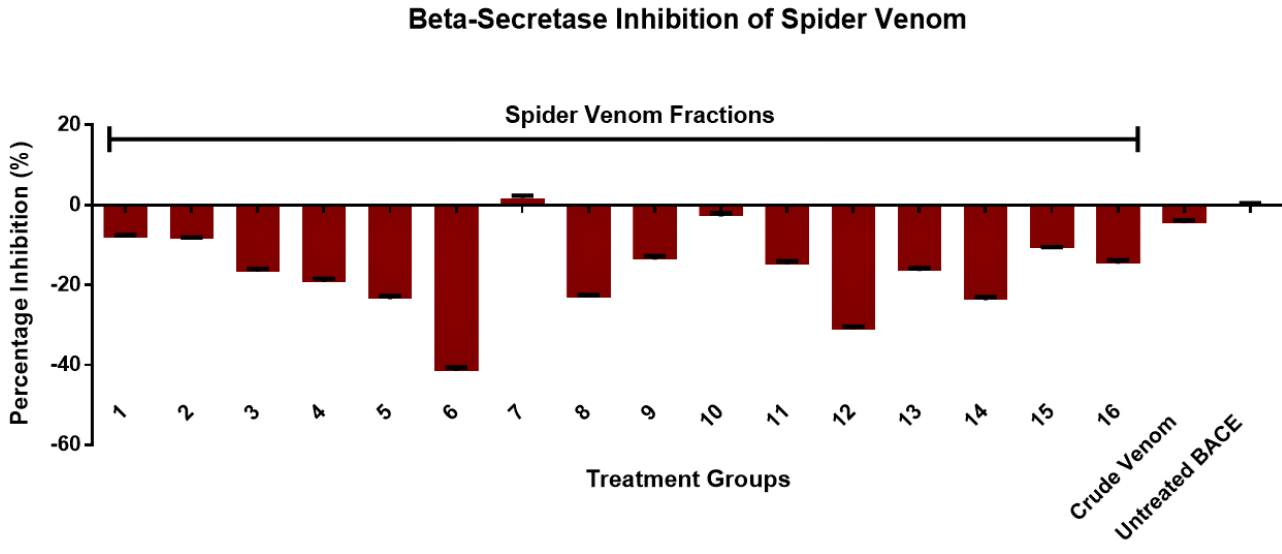
Figure 5. Screening for BACE inhibitory activities of whole and fractionated venom compared to untreated BACE reactions. Data is reported as mean ± SE (bars) (n =